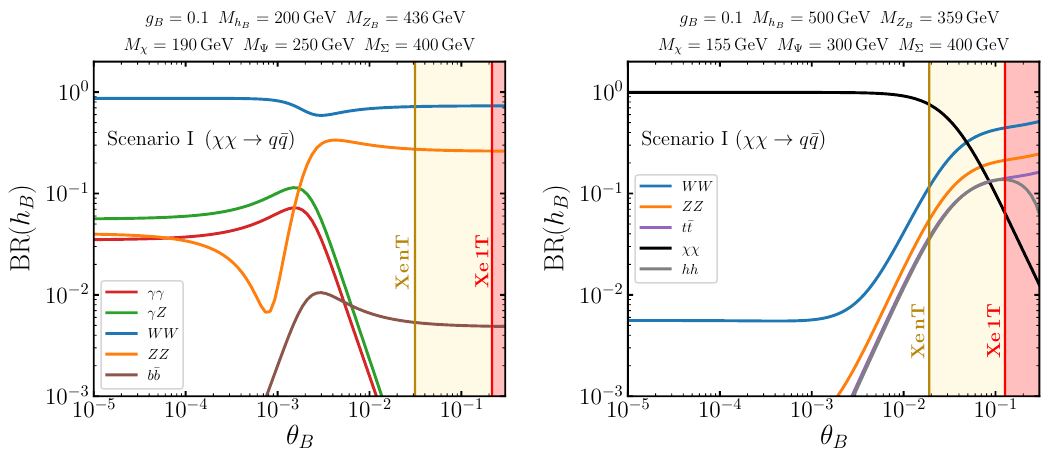
Figure 4 . Branching ratios of the Baryonic Higgs h B as a function of the scalar mixing angle θ B in the context of Scenario I, where χχ → ¯ qq is the dominant annihilation channel. The relevant parameters have been fixed as indicated in the plot to satisfy the dark matter relic density Ω h 2 = 0 . 12 . The different colors correspond to different decay channels as shown in the plot. The area shaded in red is ruled out by Xenon-1T direct detection constraints, while in yellow we show the region that will be probed by Xenon-nT.